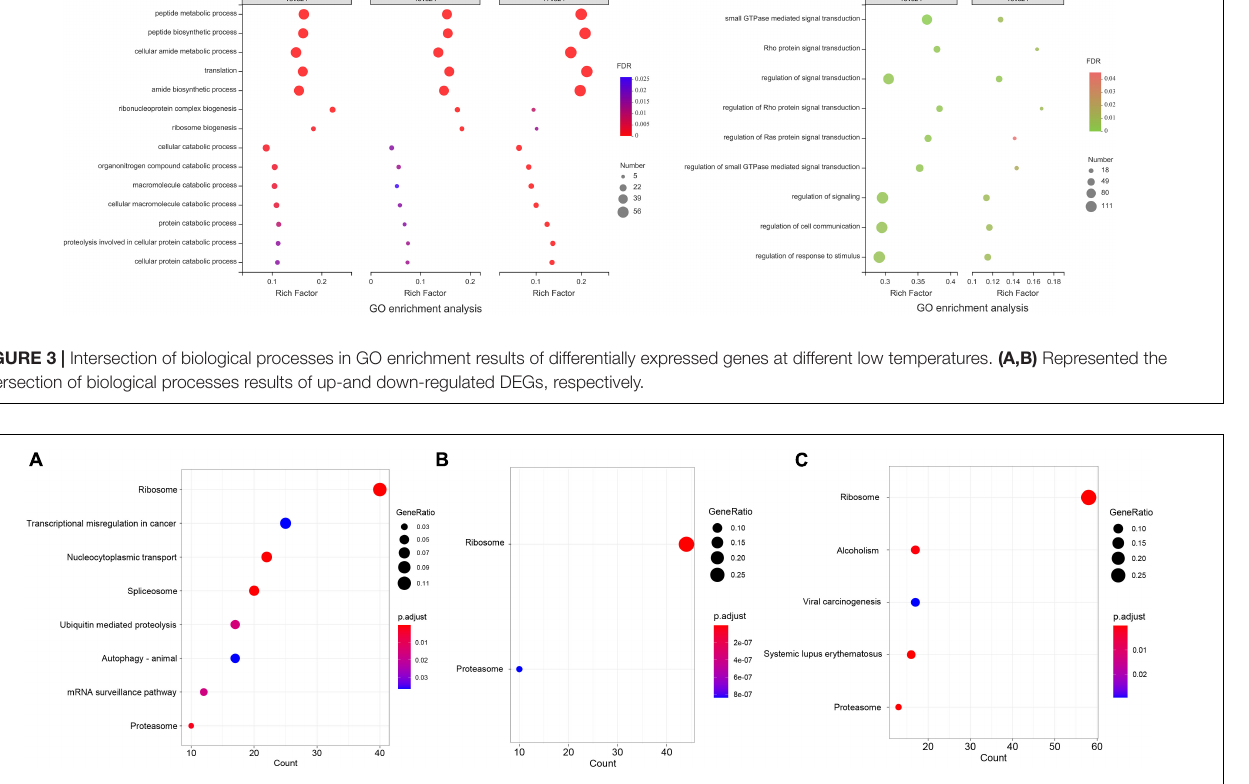
FIGURE 4 | KEGG enrichment results of up-regulated DEGs at different low temperatures. (A–C) Represented KEGG enrichment results at 13, 15, and 17 ◦ C,